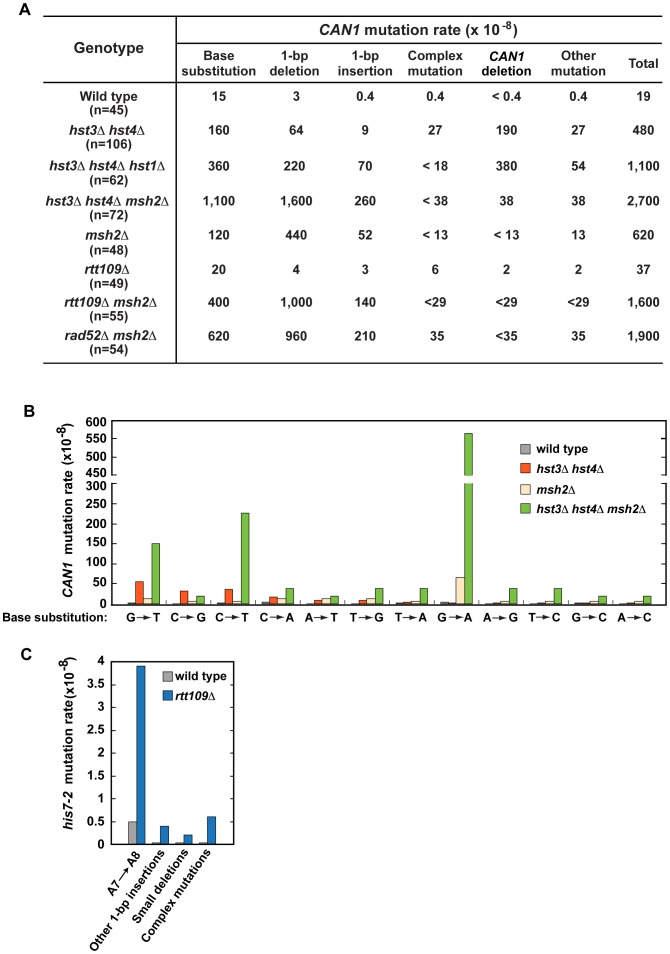
Characterization of spontaneous mutagenesis in hst3Δ hst4Δ and rtt109Δ strains.(A) Rates of the different classes of mutations in the coding strand of CAN1 gene in the indicated strains. The can1 mutations were identified by DNA sequencing as described in Materials and Methods. Deletions of CAN1 gene were detected by using PCR reactions like those shown in Figure S1. When a genomic DNA did not support PCR amplification of the CAN1 fragment but produced the POL2 fragment, the mutant was classified as one that contains a CAN1 deletion. (B) Rates of different can1 base substitutions in the wild-type and indicated mutant strains. (C) Spectra of mutations that reverted his7-2 in the wild-type and rtt109Δ strains. Forty-two mutants of either genotype were sequenced to generate the spectra.